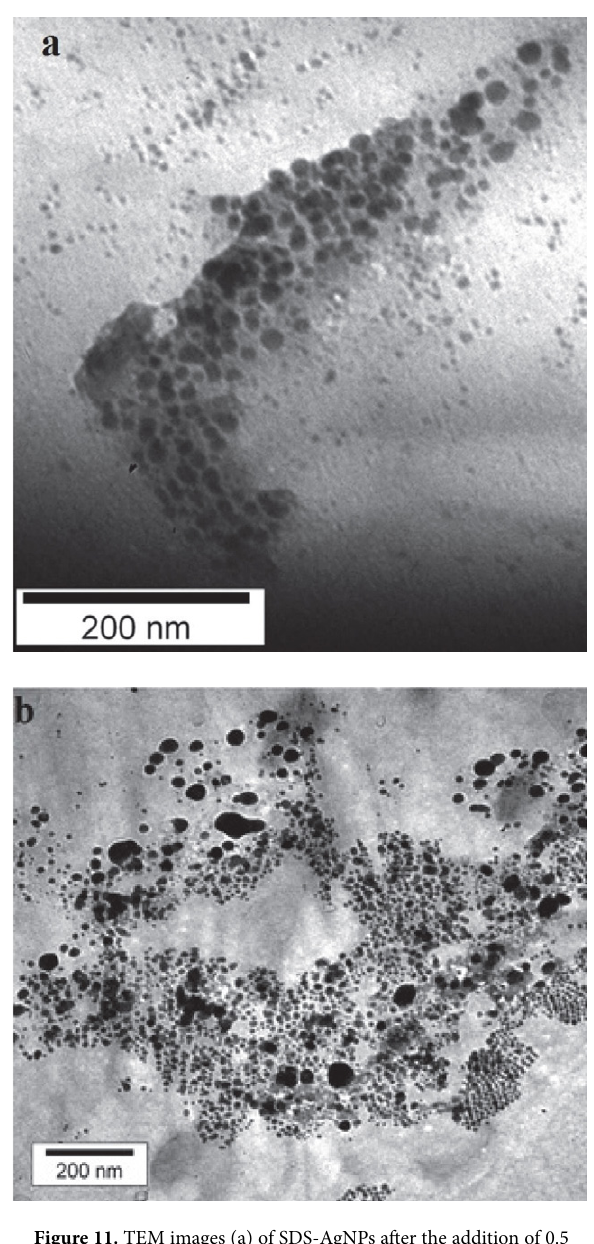
Figure 11. TEM images (a) of SDS-AgNPs after the addition of 0.5 µM of Mn 2+ ions (b) of SDS-CD-AgNPs after the addition of 0.5 µM of Cr 2+